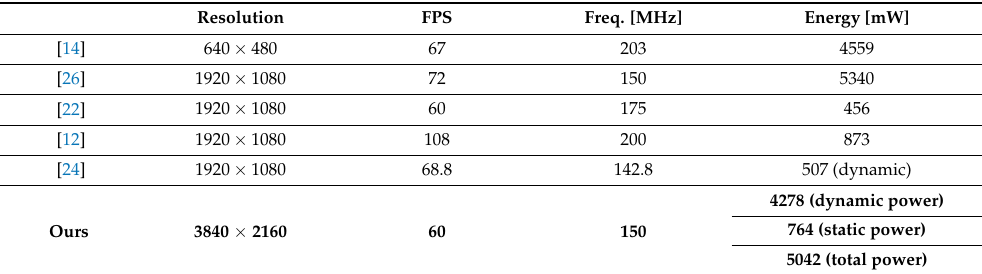
Table 5. Comparison of power consumption. We report total power (unless noted otherwise). It can be seen that due to much higher processed resolution and meeting the real-time requirement, our implementation consumes slightly more power compared to other works. However, this is an acceptable level for potential use on Unmanned Aerial